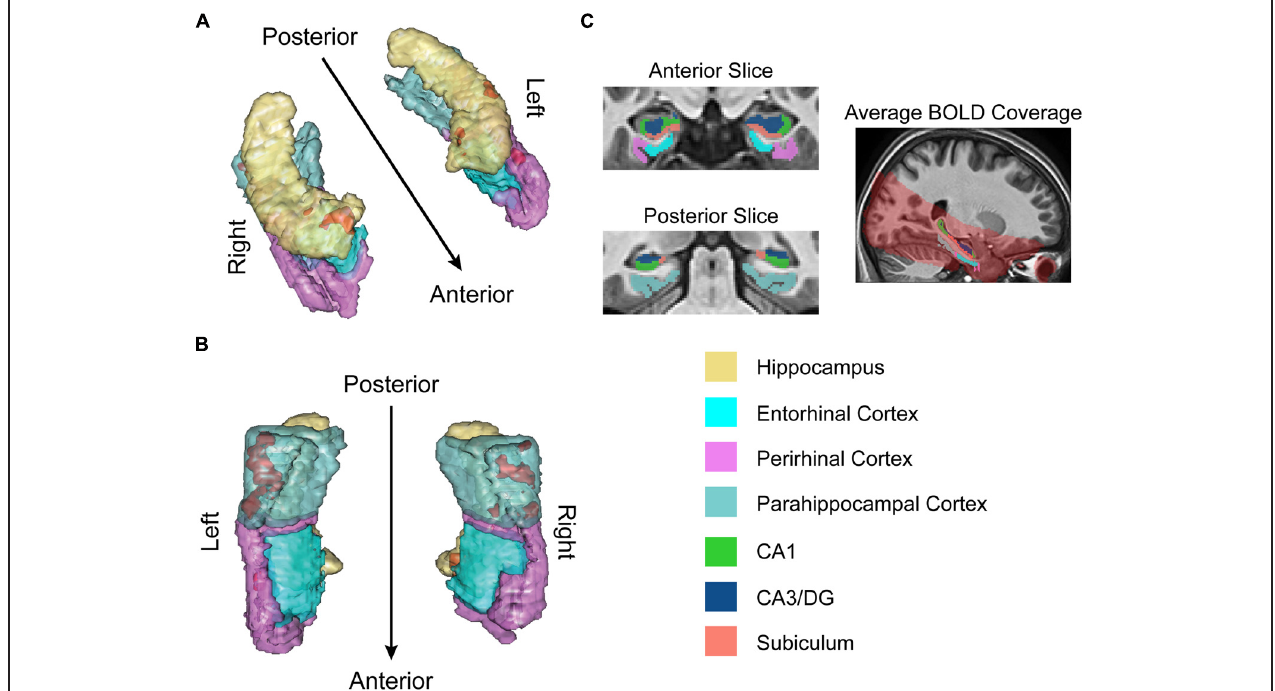
FIGURE 2 | fMRI results for ongoing encoding ( sample + delay model without signal decay). Preliminary analysis of a putative encoding epoch (sample + delay periods from DMS task; see Figure 1 ) shows regions where increased activity during DMS task performance was linearly related to stronger episodic memory at later test. Results are shown in red within 3D renderings of our regions of interest (ROIs)